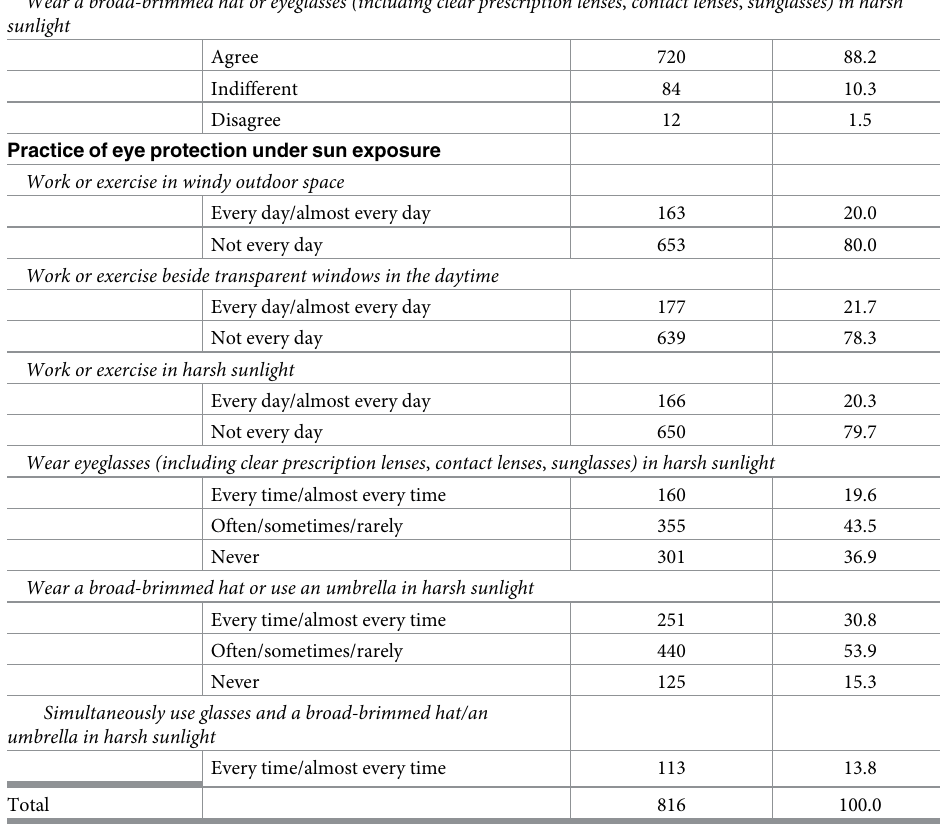
Our findings that a 57%, 45% and 70% reduction of risk of cataract in participants who used glasses, broad-brimmed hats/umbrellas, or both, respectively were paralleled with a study of Taylor et al. showing people who wore hats and sunglasses to protect their eyes from strong sun shine could substantially reduce the risk of cataracts [3]. We confirmed ocular protection against sunlight might decrease risk of cataract formation and our results corresponded with prior suggestion that additional protection means such as broad-brimmed hat might have additive protective effect of UVR when combined with glasses [23]. The current study also could be comparable with the French study, which reported professional exposure to sunlight might increase 63% of posterior subcapsular cataract, but frequent use of sunglasses might offer a 40% decrease in the risk of posterior subcapsular cataract [24]. Based on such evidence,